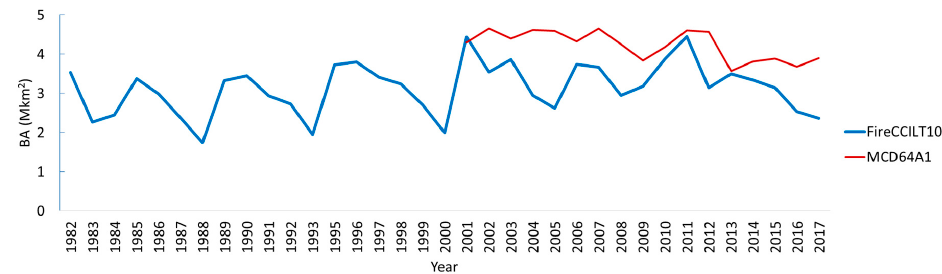
Figure 13. BA annual trends of the MCD64A1 and FireCCILT10 BA products.